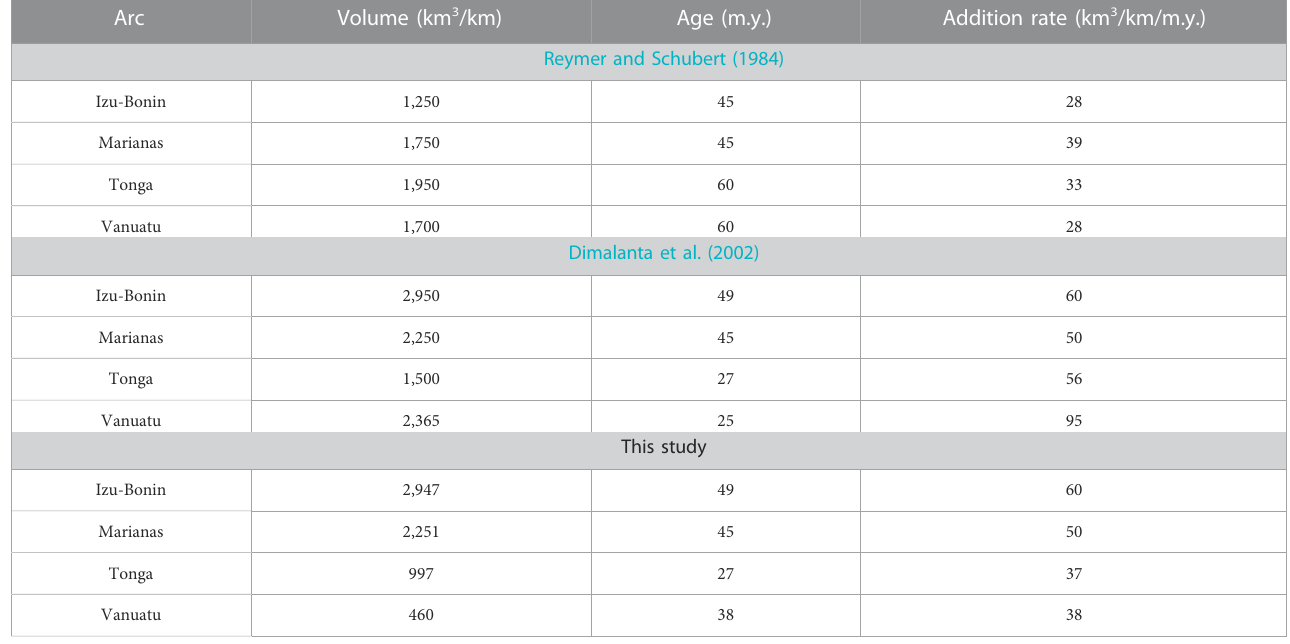
TABLE 2 Comparison of the volume, age, and magmatic addition rates between Reymer and Schubert (1984), Dimalanta et al. (2002), and this study. Arc Volume (km 3 /km) Age (m.y.) Addition rate (km 3